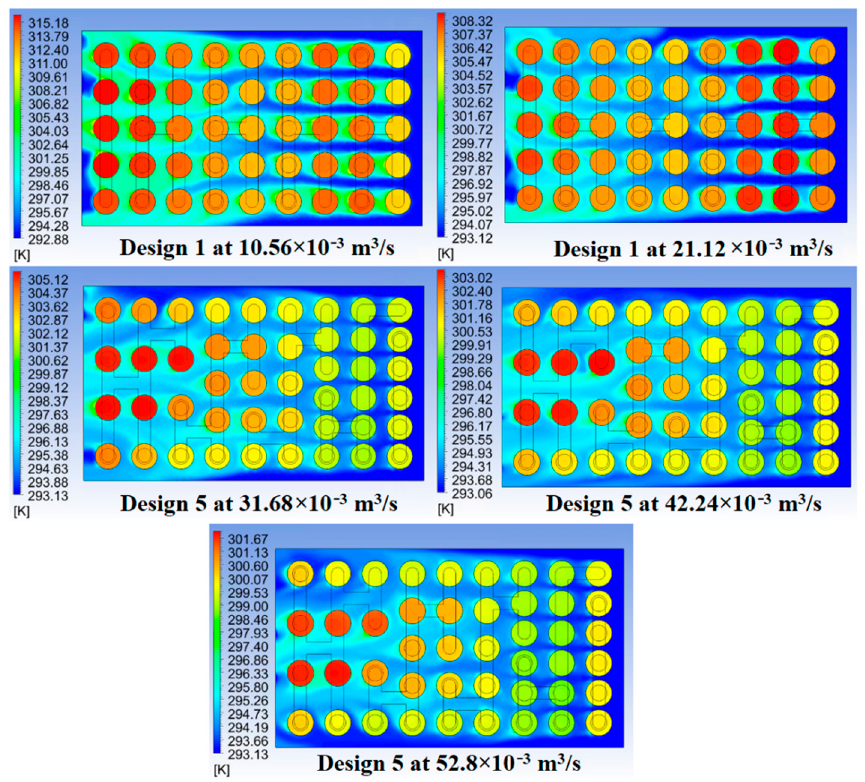
Figure 5. Maximum temperatures of 7 designs at 5 flow rates.